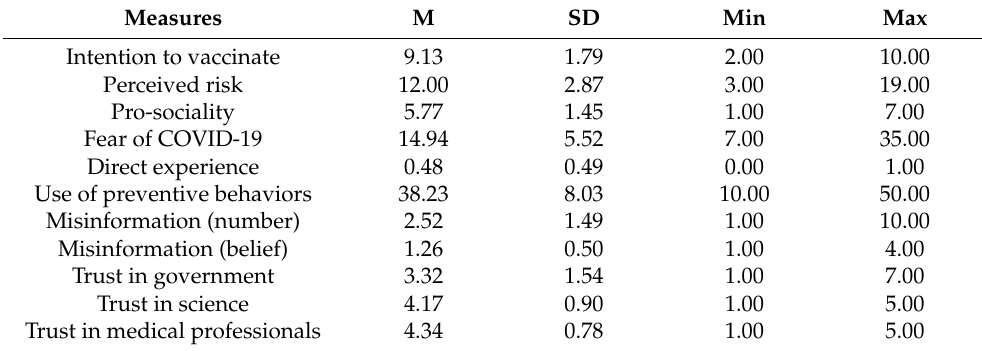
Table 2. Descriptive statistics for the variables measured in the present